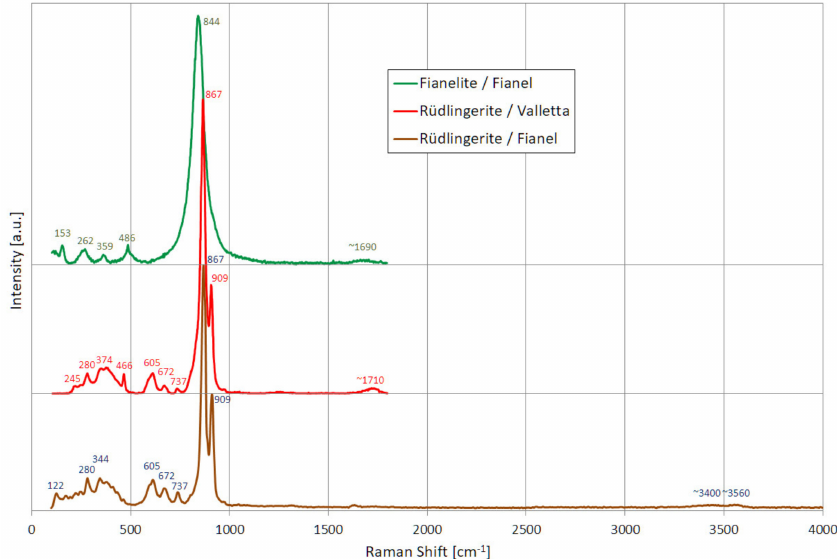
Figure 3. Comparison of the microRaman spectra of rüdlingerite and of fianelite from Fianel and of rüdlingerite from Valletta. The di ff erences between the rüdlingerite spectra and the fianelite spectrum are evident in the range 600–1000 cm − 1